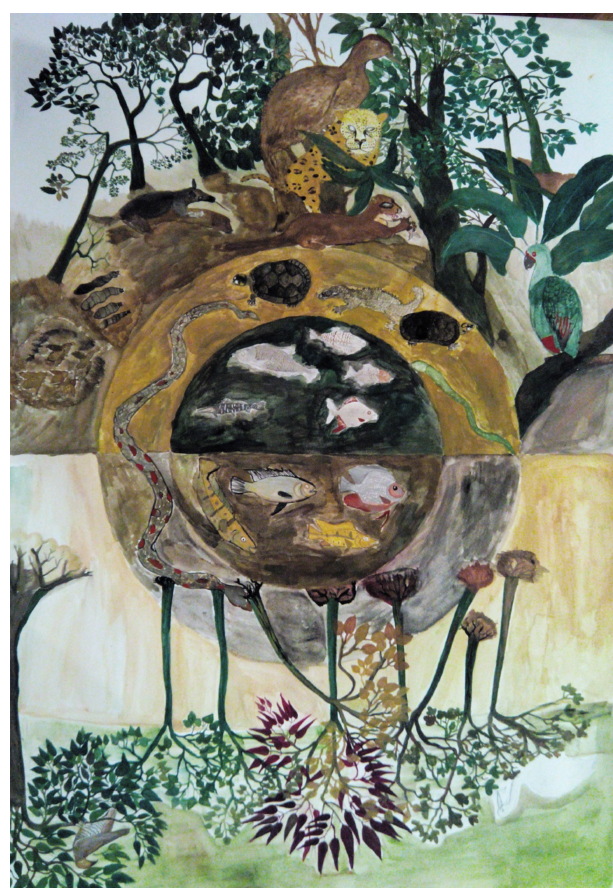
Figure 2. Painting illustrating the fauna that can be observed near the Miritî, a black water tributary of the Caquetá river. The upper half-sphere represents the dry season, when most of the terrestrial animals are present in this area. The lower half-sphere represents rainy season, when animals move deep into the terra firme forest or to the head waters. With the beginning of the dry season animals feed on what remained from the flood and some species (turtles and caimans) lay their eggs, which are often consumed by terrestrial animals. This original water painting was illustrated by Marcela and Johana Yucuna, indigenous of the Yucuna ethnic group from the Mirití region (Caquetá, Colombia). The painting is reproduced with the permission of the